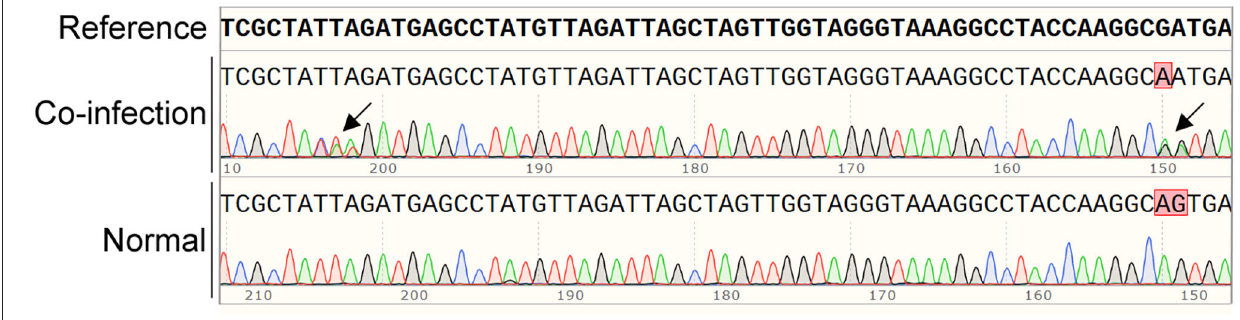
FIGURE 1 | Typical co-infection with various Anaplasma spp. are indicated by overlapping in the sequencing analysis with SnapGene software. The overlapping peaks are indicated by black arrows.